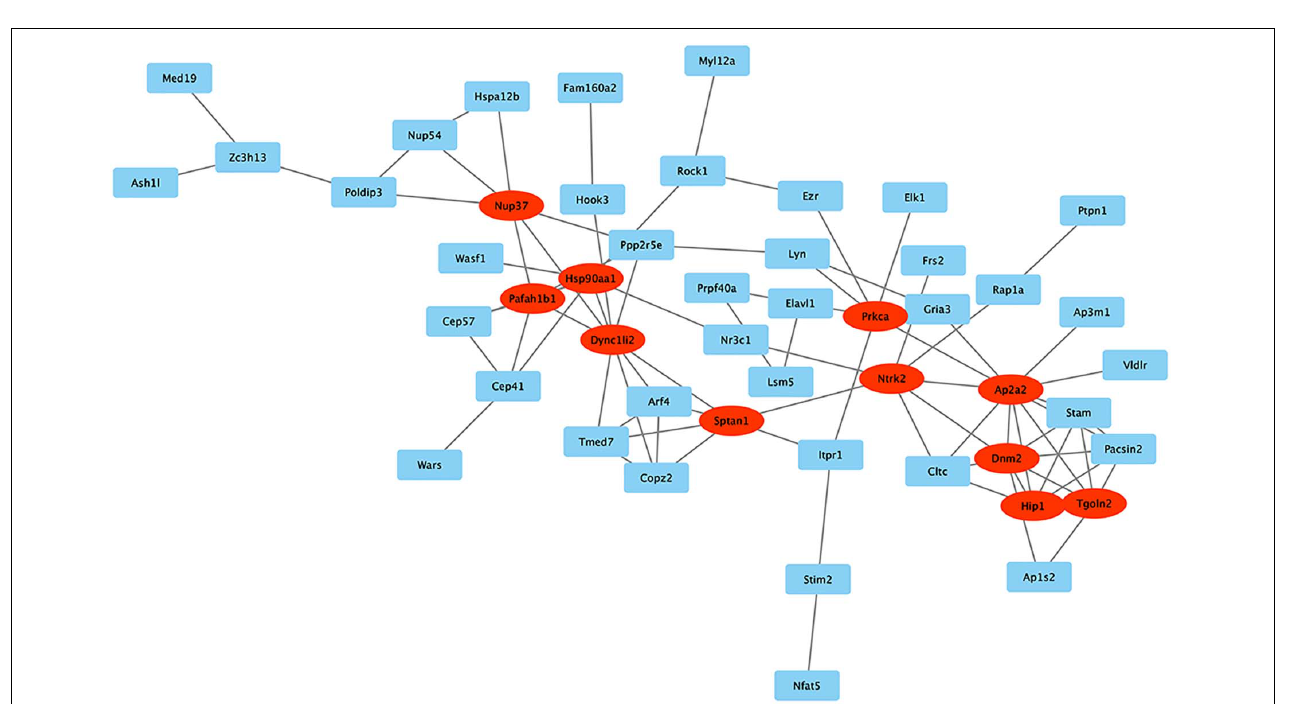
FIGURE 7 | PPI network. STRING was used to predict protein interactions among the mRNA. The circRNAs with interaction scores > 0.7 (high confidence) were chosen to construct PPI networks. Proteins with > 5 relationships with other proteins are represented by ovals and may be the hub proteins in this network.